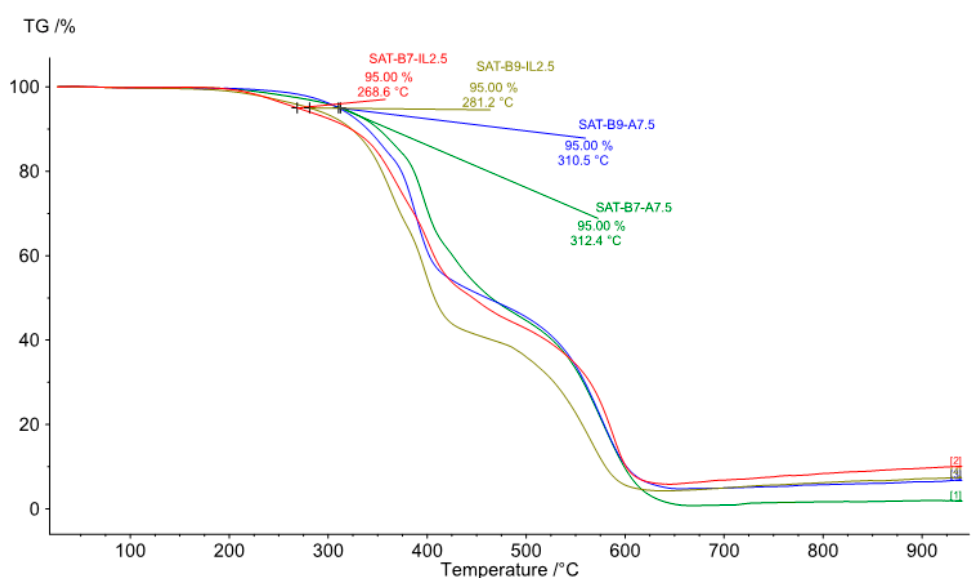
Figure 13. TGA curves under a N 2 atmosphere of thermally cured SATs (195 °C for 60 min).